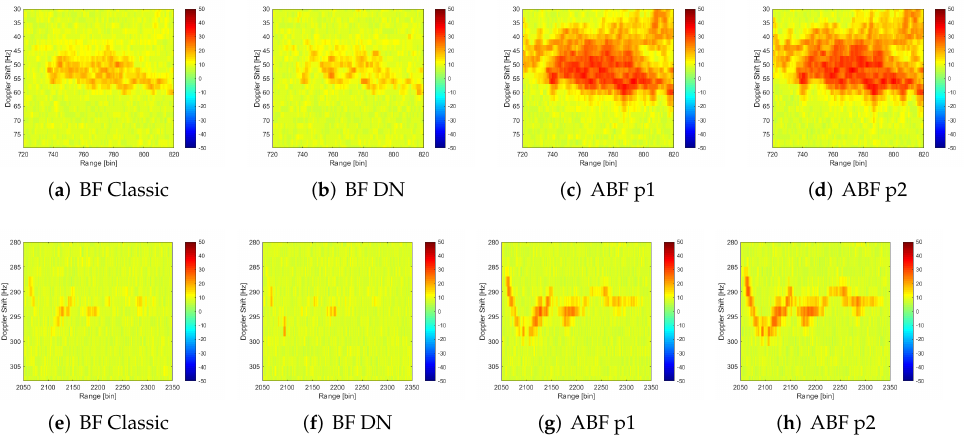
Figure 15. Cumulative of RD maxima zoomed at targets regions ( a – d maritime target and e – h aerial one) for classic beamforming and the solutions proposed for interference suppression: deterministic nulls generation (DN), adaptive beamforming with sample matrix estimation following first proposal (ABF 1) and second proposal (ABF 2).